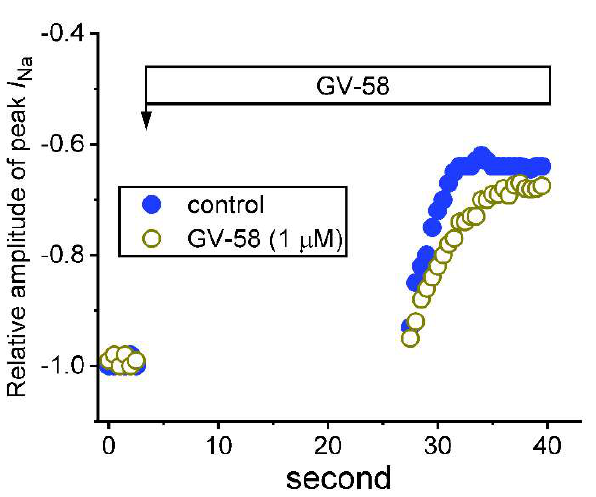
Figure 6. Tonic and use − dependent stimulation of peak I Na by GV − 58. The cell was held at − 80 mV, and the depolarizing pulse from − 80 to − 10 mV (30 ms in duration) was applied at 2 Hz. The application of GV − 58 (1 µ M) is illustrated by a horizontal bar shown above. Changes in the relative amplitude of peak I Na with or without the addition of GV − 58 (1 µ M) are illustrated. The peak I Na in the absence (filled circles) or presence (open circles) of GV − 58 measured during regular repetitive steps at 0.5 Hz was taken as − 1.0. Immediately after the voltage pulses were stopped, GV − 58 (1 µ M) was added to the bath. The repetitive depolarizing pulses to − 10 mV at 2 Hz were applied again 25 s after the cessation of command pulses but still in the continued presence of GV − 58 (1 µ M) (open circles). Of notice, in the presence of GV-58, the peak I Na activated by the first depolarizing step following a pause (around 25 s) had been suppressed to a lesser extent (i.e., tonic stimulation), and, during the repetitive stimuli, the amplitude of peak I Na was further reduced exponentially to a lesser and slower extent (use − dependent stimulation).